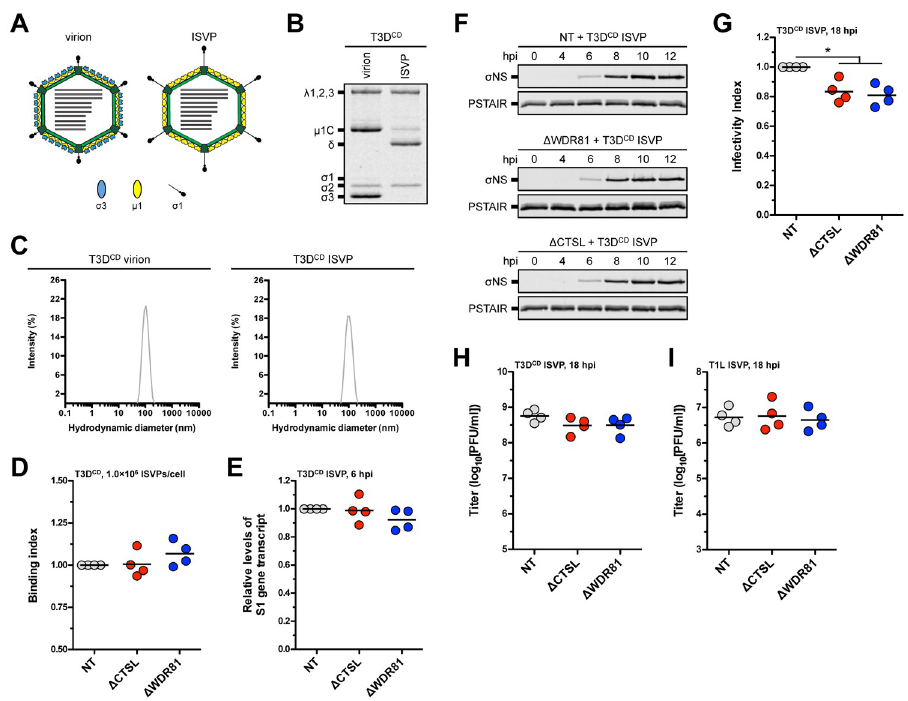
Fig 5. Infection of WDR81-deficient cells by T3D CD or T1L ISVPs. (A) Schematic of reovirus virions and ISVPs. (B) Protein compositions. T3D CD virions and ISVPs were analyzed by SDS-PAGE. The gel was Coomassie brilliant blue stained. The migration of capsid proteins is indicated on the left. μ 1 resolves as μ 1C, and μ 1 δ resolves as δ [74] (n = 4 biological replicates; results for 1 representative experiment are shown). (C) Size distribution profiles. T3D CD virions and ISVPs were analyzed by dynamic light scattering (n = 4 biological replicates; results from 1 representative experiment are shown). (D) Viral attachment. NT, Δ CTSL, and Δ WDR81 cells were adsorbed with T3D CD ISVPs at 1.0 × 10 6 particles/cell, and the binding index was measured using indirect immunofluorescence. Horizontal bars indicate the means (n = 4 biological replicates). (E) Viral RNA transcription. NT, Δ CTSL, and Δ WDR81 cells were infected with T3D CD ISVPs at 5 PFUs/cell. At 6 h post infection (hpi), the levels of the reovirus S1 gene transcript were measured using quantitative reverse transcription-PCR. Horizontal bars indicate the means (n = 4 biological replicates). (F) Initiation of viral protein synthesis. NT, Δ CTSL, and Δ WDR81 cells were infected with T3D CD ISVPs at 5 PFUs/cell. At the timepoints indicated in the figure, the levels of the reovirus σ NS protein and the PSTAIR epitope of the host protein CDK1 were measured by Western blot. The migration of σ NS and PSTAIR are indicated on the left (n = 3 biological replicates; results from 1 representative experiment are shown). (G) Levels of infectivity. NT, Δ CTSL, and Δ WDR81 cells were infected with T3D CD ISVPs at 5 PFUs/cell. At 18 hpi, the infectivity index was measured using indirect immunofluorescence. Horizontal bars indicate the means; � , P � 0.05 (n = 4 biological replicates). (H and I) Production of infectious virus. NT, Δ CTSL, and Δ WDR81 cells were infected with T3D CD or T1L ISVPs at 5 PFUs/cell. At 18 hpi, the amount of infectious virus produced was measured using plaque assay. Horizontal bars indicate the means (n = 4 biological